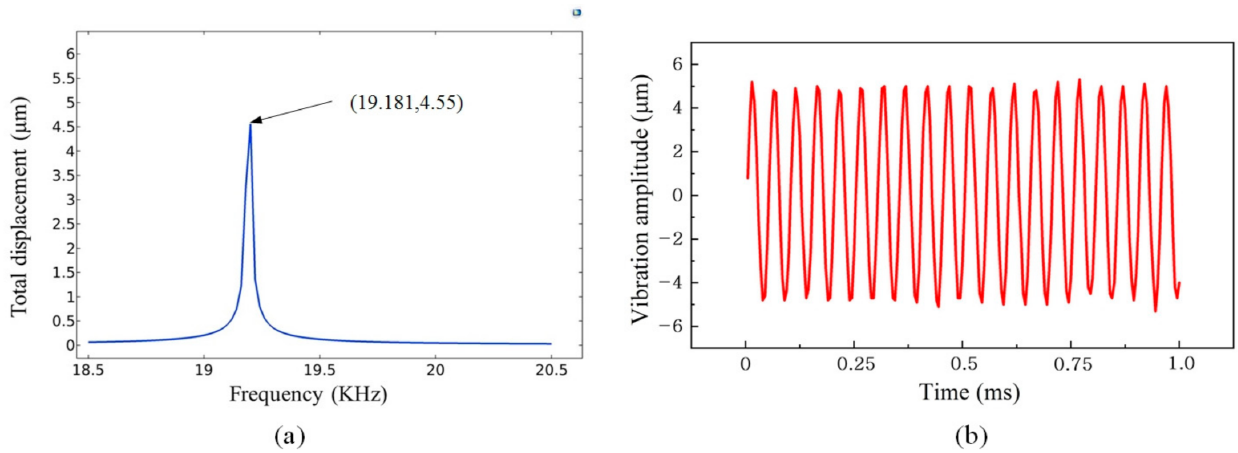
Figure 5. Ultrasonic vibration amplitude of grinding tool working face: ( a ) simulation results, and ( b ) test